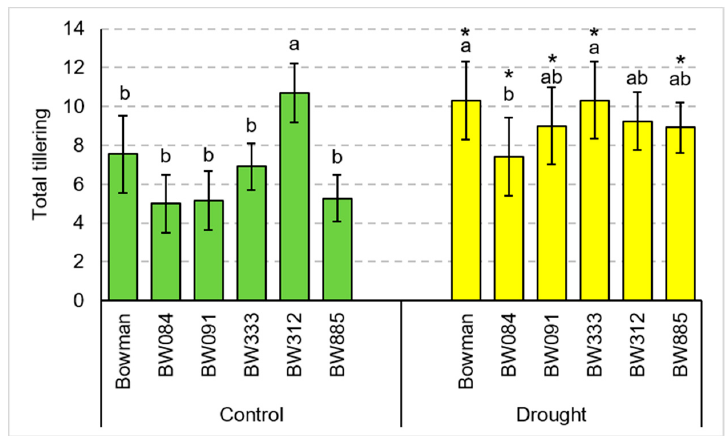
Figure 2 . Total tillering (total number of tillers, including sterile tillers) of the analyzed genotypes under the optimal watering (control) conditions and after the drought stress (the pot experiment). The mean values ± (SD) marked with the same letters (separately for the control and drought-stressed plants) are not significantly different, according to Duncan’s test ( p ≤ 0.05). Asterisks denote significant difference in comparison of values reported in each genotype between the control and drought conditions according to Student ’ s t -test. Details are given in the text.